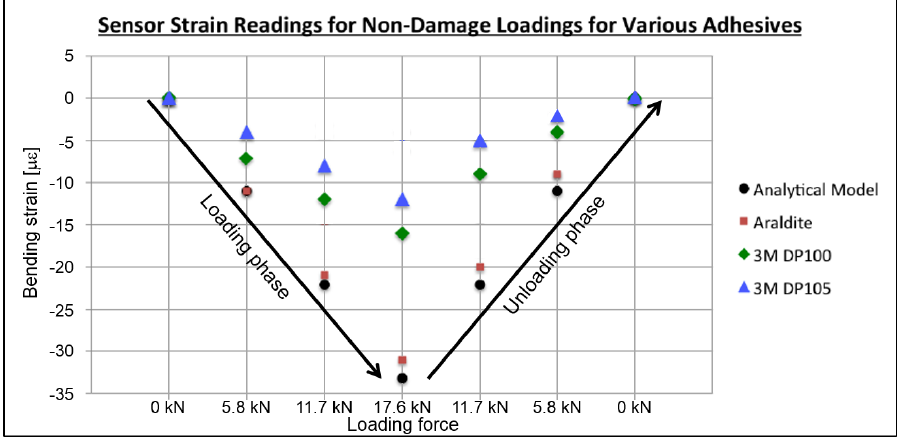
Figure 8. Strain transfer results for various